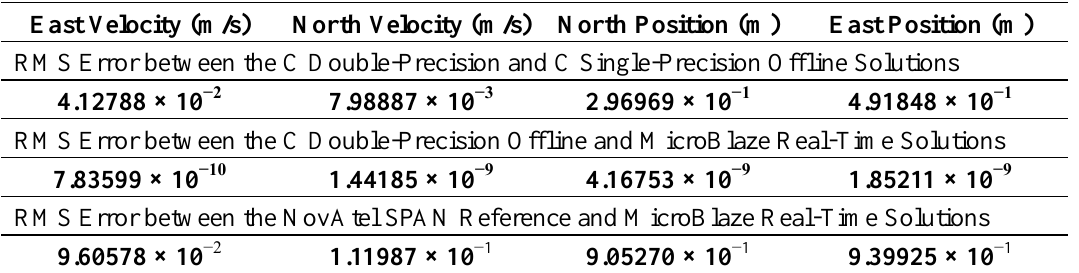
Table 3. RMS Error in the East Velocity, North Velocity, North and East Positions over Mobile Robot Trajectory (1).